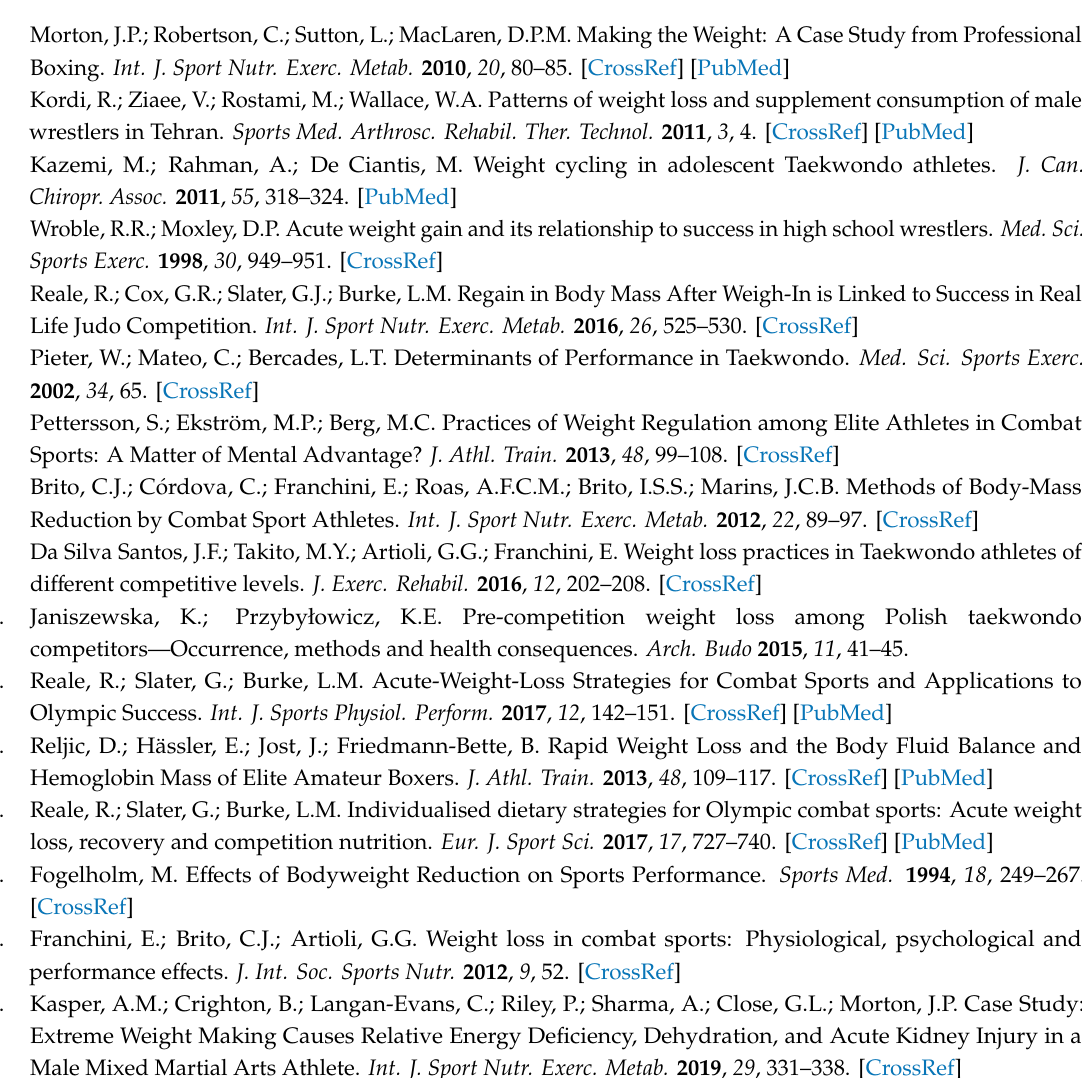
Table S1: Percentage of athletes using individual weight loss methods in the identified weight loss models [%]. File S1: Polish and English version of Pre-competition Weight Loss